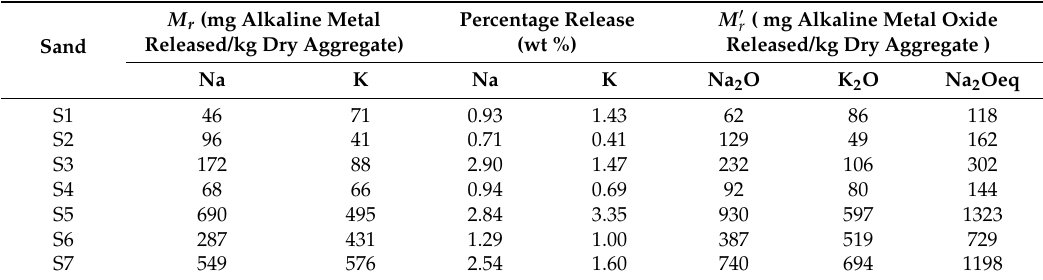
Table 5. Alkali releases from all the sands investigated under optimal test